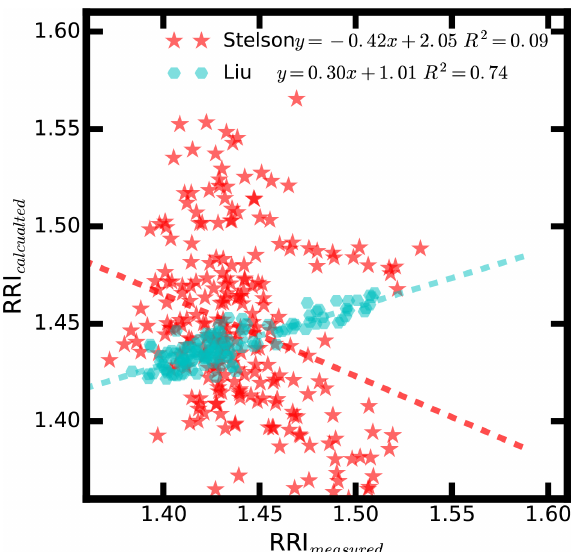
Figure 8. Comparison between the measured RRI and calculated RRI using the main aerosol chemical component by applying the method of Stelson (1990) (red stars) and the parameterization scheme proposed by Liu and Daum (2008) (cyan hexagons).